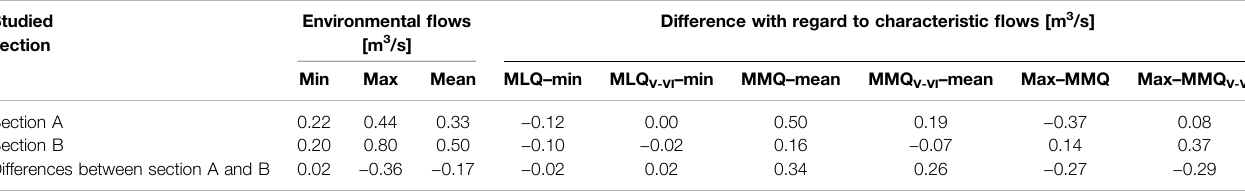
TABLE 2 | Summary of environmental fl ows values and comparison to characteristic fl